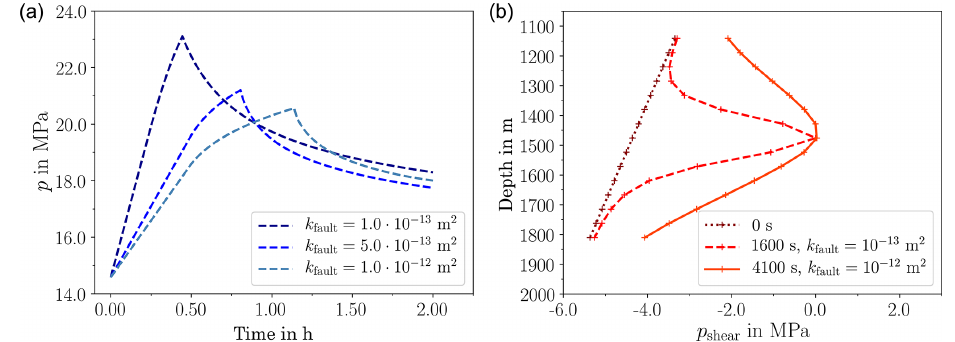
Figure 7. (a) Pressure evolution over time for different fault permeabilities. (b) Distribution of the pressure margins for shear failure along the fault for different permeabilities.